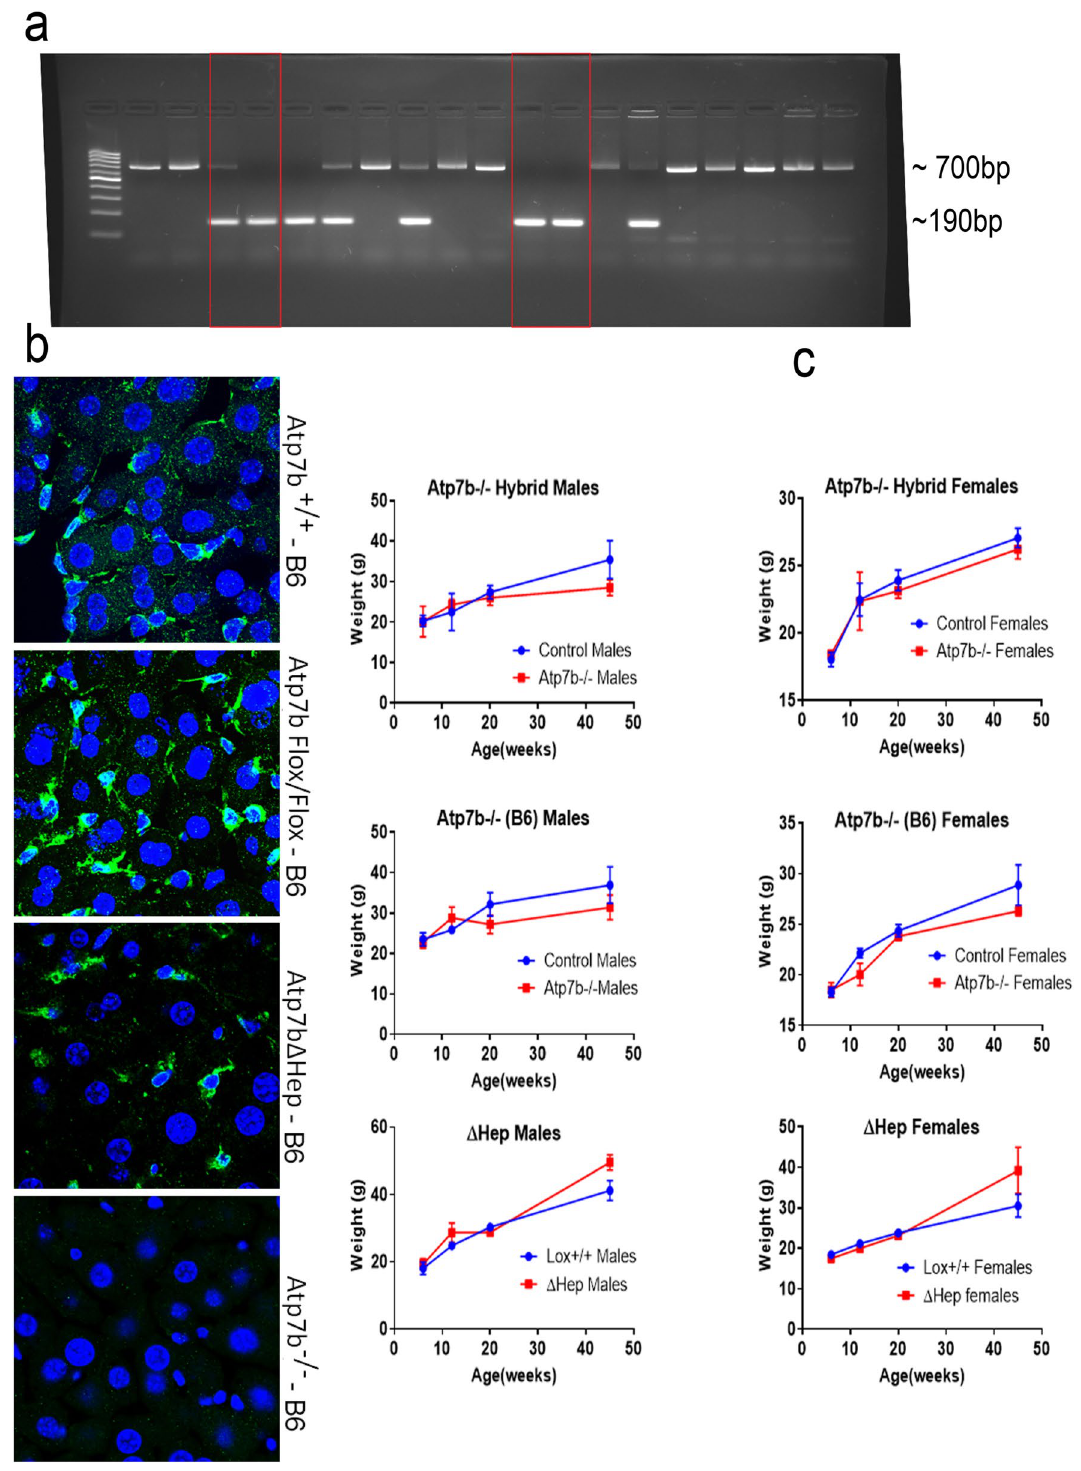
Figure 1. Characteristics of Atp7b − / − mice on C57BL/6 J background ( Atp7b -/– B6 ). ( a ) Genotyping littermates to identify the Cre-mediated deletion. The 190 bp product is indicative of the desired deletion within Atp7b (red boxes). The 700 bp product reflects the wild-type genotype. ( b ) The livers from 6-weeks old mice were sectioned, immuno-stained with anti-ATP7B antibody (green) and DAPI (nuclei, blue), and then imaged using an LSM 800 confocal microscope. In the wild-type ( Atp7b + / + ) and Atp7b Flox/Flox livers, ATP7B (green) is detected in both hepatocytes (large cells with large nuclei) and non-parenchymal cells (small cells with small nuclei). Atp7b ΔHep -B6 mice show staining predominantly in small non-parenchymal cells. No ATP7B staining is seen in Atp7b -/– B6 livers . ( c ) Comparison of the weight gain curves for Atp7b-mutant mice (blue), males and females, and the background-matched control animals (red); each point represents an average of data from 3–11animals. Individual weights and statistical analysis of weight differences between the Atp7b − / − mice and the background-matched wt controls at 20 weeks and at 45 weeks are given in Supl. Fig.